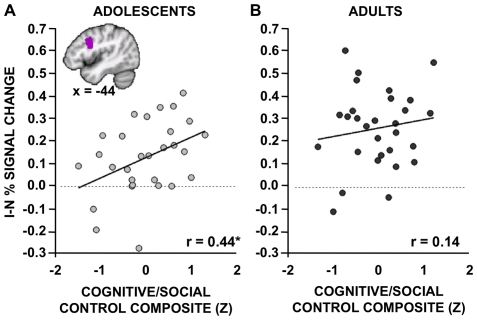
Relationships between blocked Stroop activity and self-report measures of cognitive/social control.Percent signal change reflecting the contrast of Incongruent (I) vs. Neutral (N) blocks was extracted from the IFJ/pDLPFC seed that exhibited group differences in Figure 1C (see box in
Figure 1C
 and inset in current figure). Activity within this region was correlated with self-report measures of cognitive/social control separately for A. adolescents and B. adults. The cognitive/social control composite represents participants' average z-scores from individual questionnaires assessing impulse control, planning, and resistance to peer pressure. A. In adolescents, a significant positive relationship between the two variables was observed such that adolescents who activate the a priori region to a greater degree reported greater cognitive/social control. B. The relationship in adults, although positive, was not significant. Note: *p<0.05.